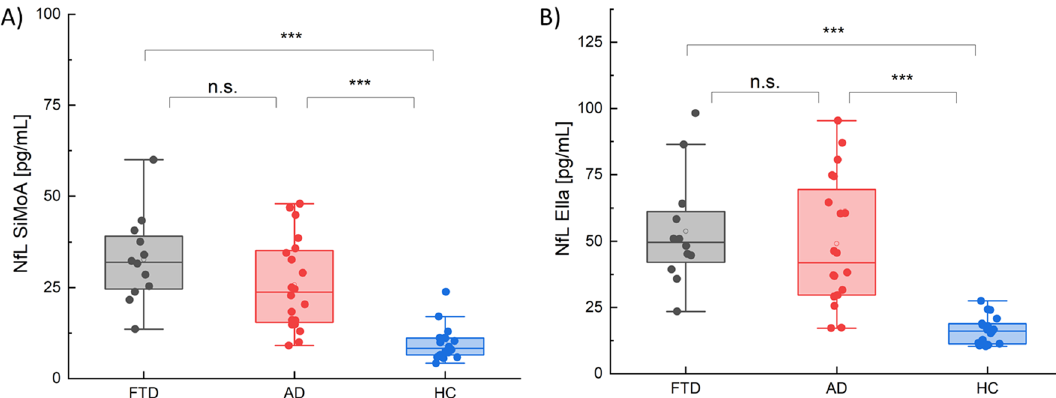
Figure 3. ( A ) Plasma levels of NfL measured by SiMoA in FTD, AD and HC. ( B ) Plasma levels of NfL measured by Ella in FTD, AD and HC. Each data point represents an individual subject analysed. Each box represents the area between the 25th and 75th percentiles [interquartile range, IQR]. Lines inside the boxes represent the median values. White dots represent the mean value for each class. Whiskers extend to the lowest and highest values within 1.5 times the IQR from the